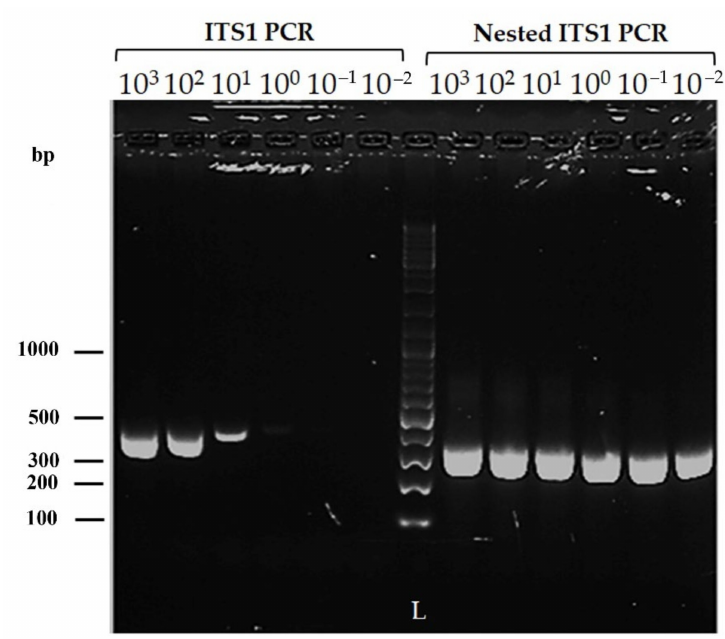
Figure 2. Sensitivity of ITS1 and modified nested PCR using L. donovani DD8